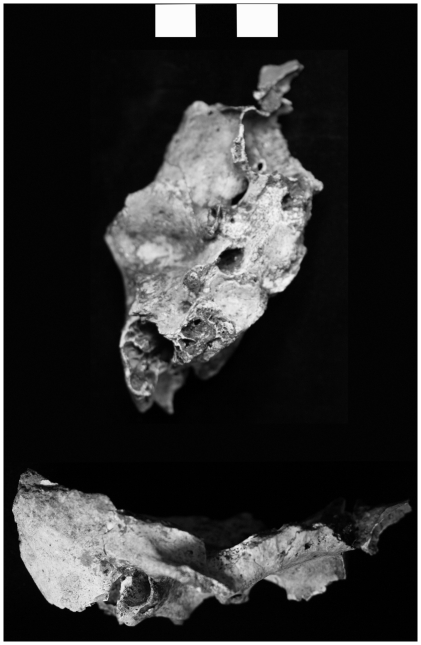
Longlin 1 temporal fragment (each bar = 1 cm).